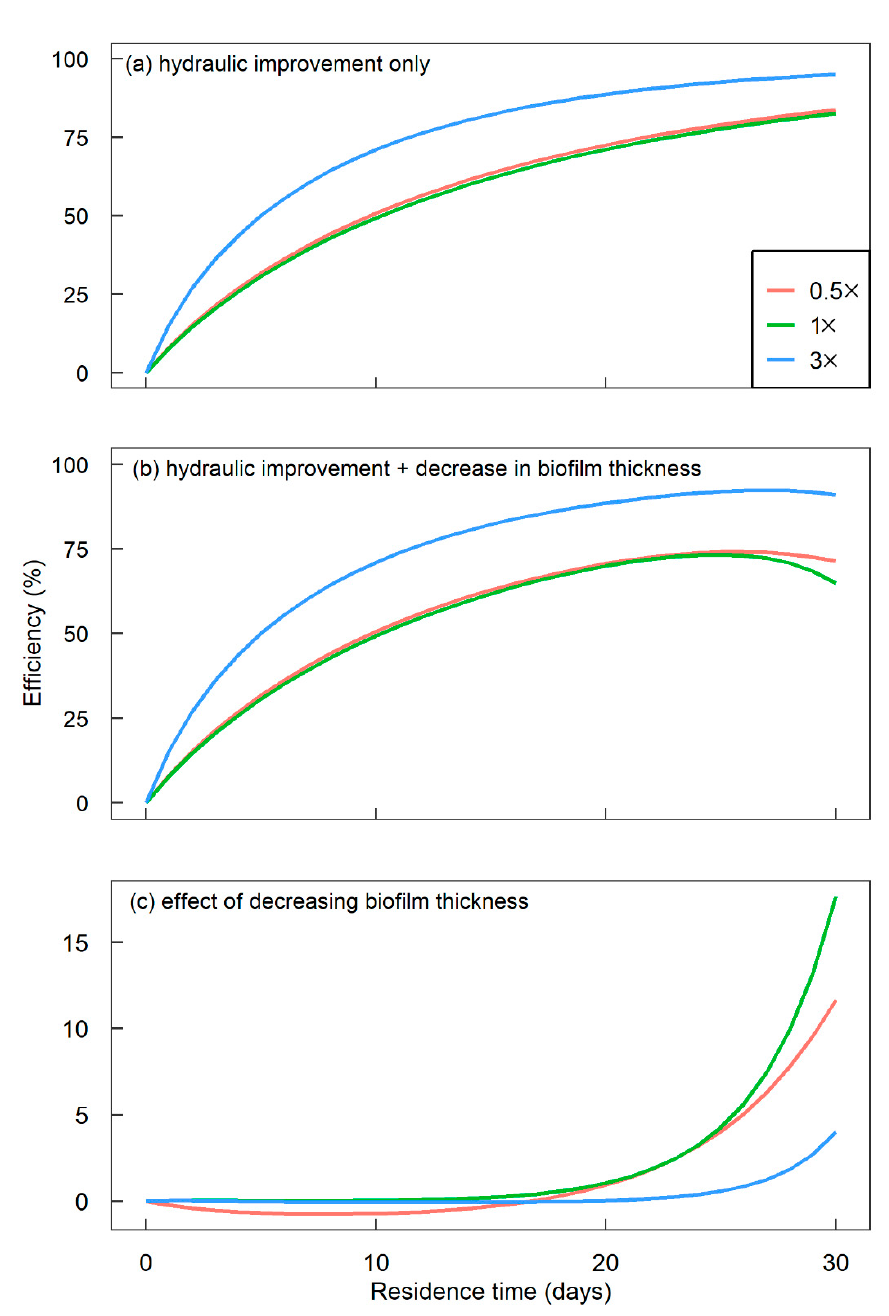
Figure 7. Comparison of biological oxygen demand (BOD) removal efficiency under three scenarios, 0.5 × (red), 1 × (green), and 3 × (blue) loading, shown as: ( a ) hydraulic improvement only, ( b ) hydraulic improvement with a decrease in biofilm thickness, and ( c ) effect of decreasing biofilm thickness only, calculated as the difference between scenarios shown in ( a , b ). The reduction of biofilm thickness within a certain range does not have a significant impact on final effluent quality.